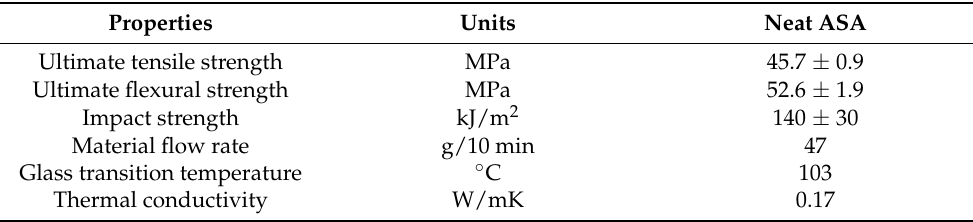
Table 1. Properties of ASA [6]. Copyright 2020 with permission from Elsevier.